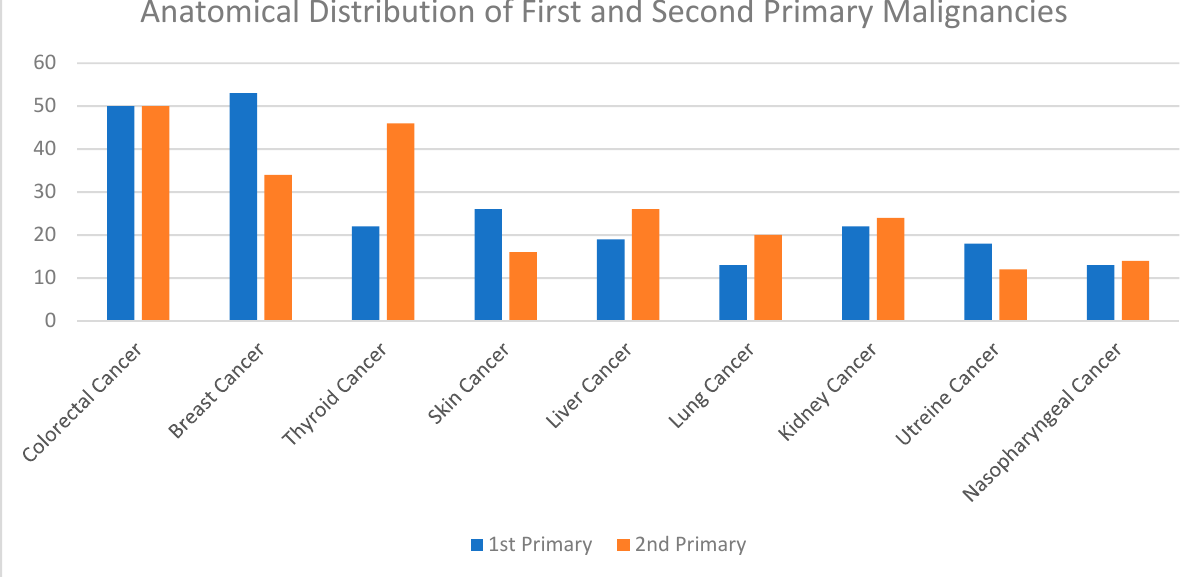
Figure 3. Shows the most frequent site of the first and second primary malignancies. Breast cancer was the most common first primary diagnosis, followed by colorectal and skin cancers. Colorectal cancer was the most frequent second primary diagnosis, followed by thyroid and breast cancers.